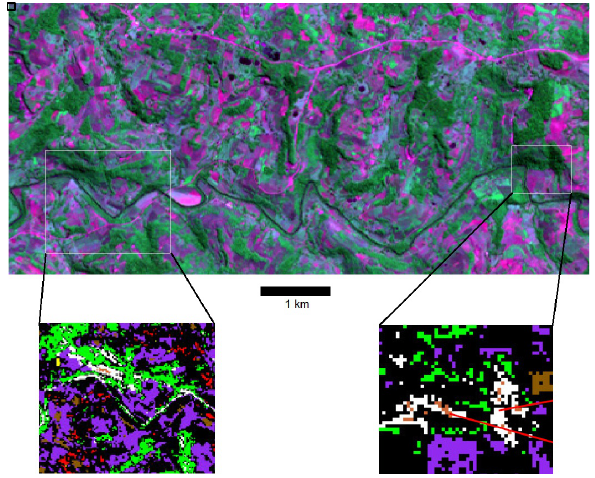
Figure 5. Misclassification between “Shadow” and “Mining residues/basalt” classes. Shadow Pixels were classified like mining residues/basalt (white color).